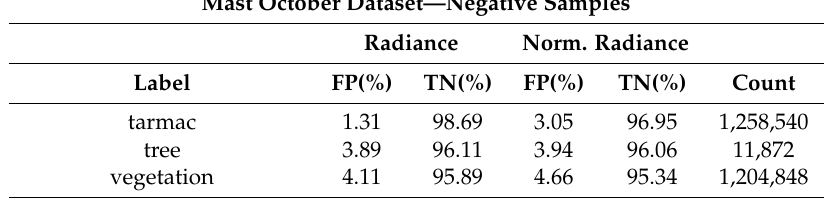
Table 5. Classification results of manually annotated data. FP = False Positive, TN = True Negative, TP = True Positive, FN = False